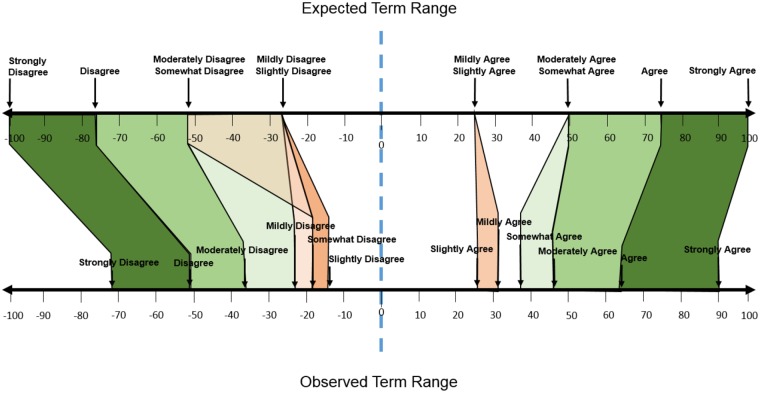
Comparison of the assumed quantitative locations of the theoretical anchor term (top scale) versus the experimentally determined anchor term positions derived from empirical observation (bottom scale).Negative valence terms showed a larger shift towards the center point, as compared with their matched positive valence terms.